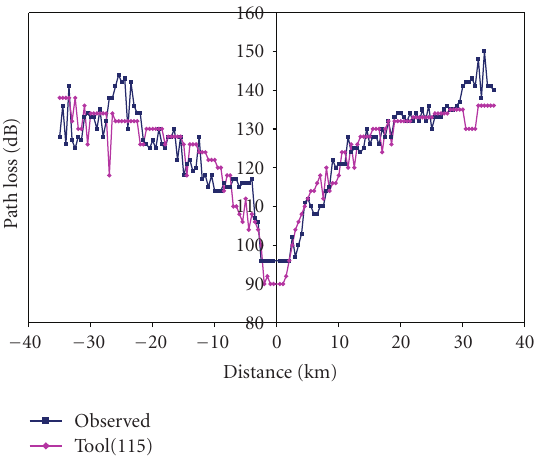
Figure 6: Comparison of tool predicted losses with observed losses versus track distance for Muza ff arnagar base